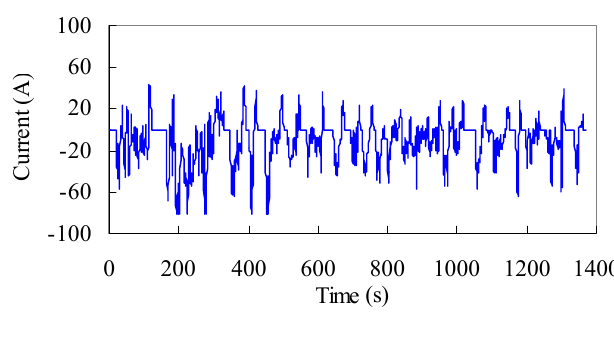
Figure 18. Current profile of